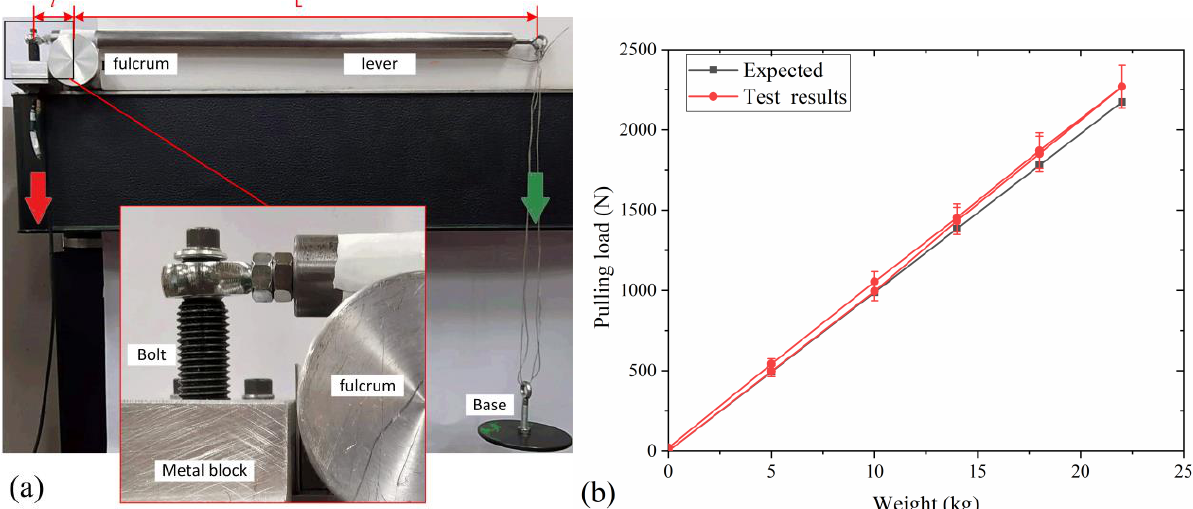
Figure 8. The bending vibration, ( a ) two-beam joint (472 Hz), ( b ) one monolithic beam (854 Hz).